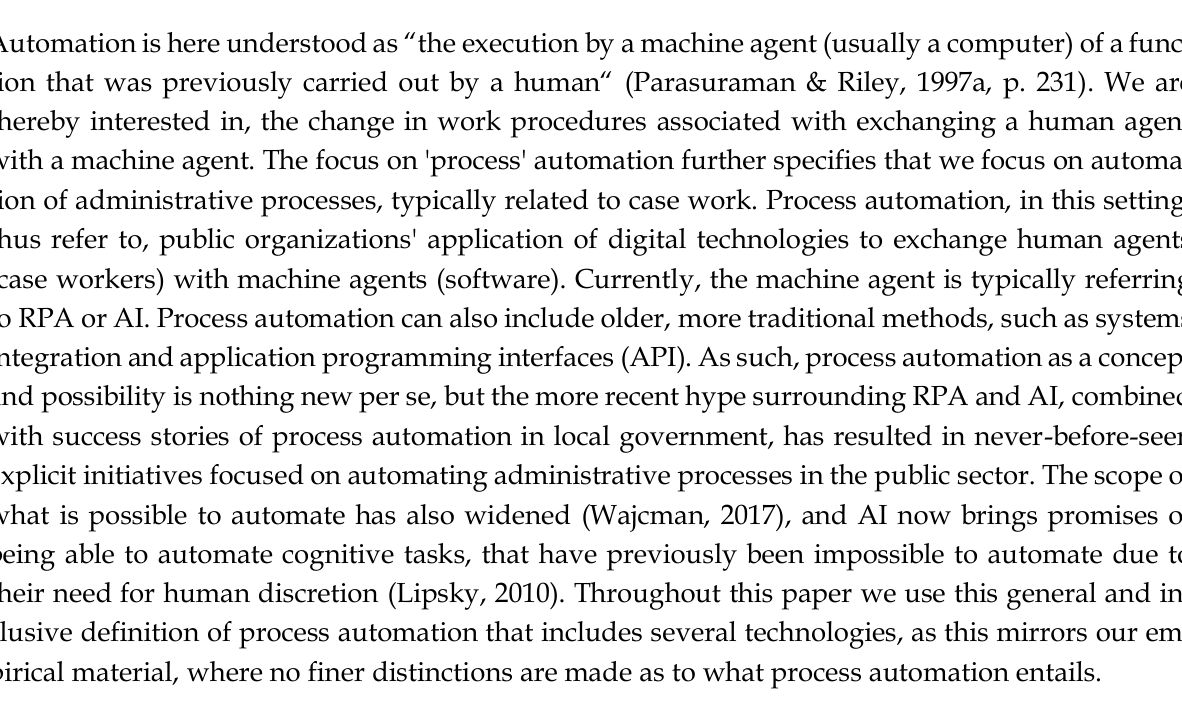
Table 1. Stakeholder roles in E-Government projects (Heeks,